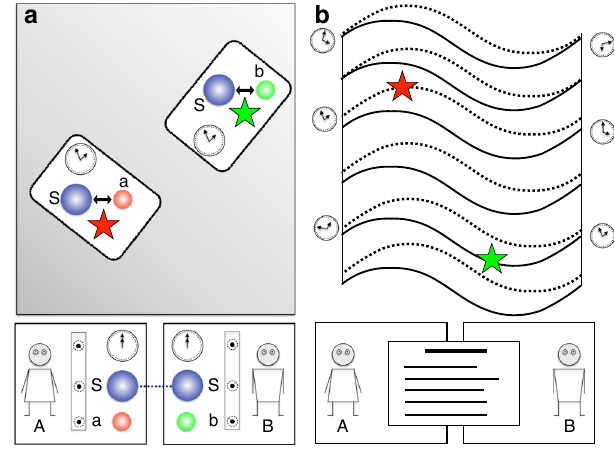
Fig. 1 Description of the operational meaning of the framework. A and B perform experiments on S in two stages. In the preparation stage ( a ), A and B specify the states of their clocks, subsystems (depicted by a blue ball) and ancillas (depicted by a red ball, a for A and by a green ball, b for B). They do so by freely choosing the knob settings that control these systems. S can be a composite system entangled between A and B. This is